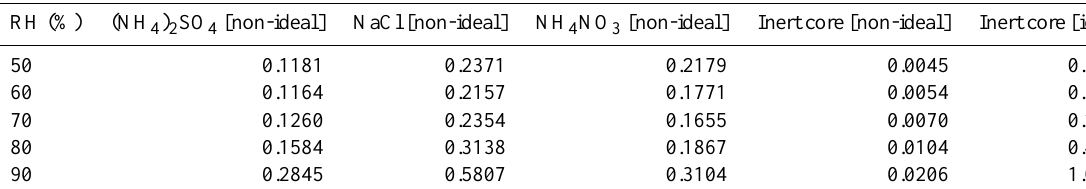
Table 4. Predicted total organic mass loadings (µgm − 3 ) from the most abundant 30 compounds generated from a gas phase degradation mechanism including both ideal and non-ideal solution thermodynamics. The composition of the core, with an abundance of 2µgm − 3 , along with the assumption of solution ideality/non-ideality, is given above each column. For the “inert core” a molecular weight of 200gmol − 1 was used, with solution thermodynamics accounting for interactions only between water and organic condensates.